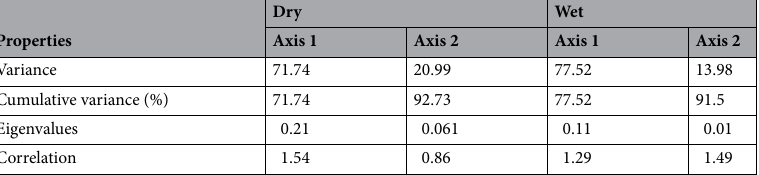
Table 5. Properties of the RLQ analysis for the FFGs, environment and taxa datasets collected in the Niger Delta Streams during the study period (2008–2012).